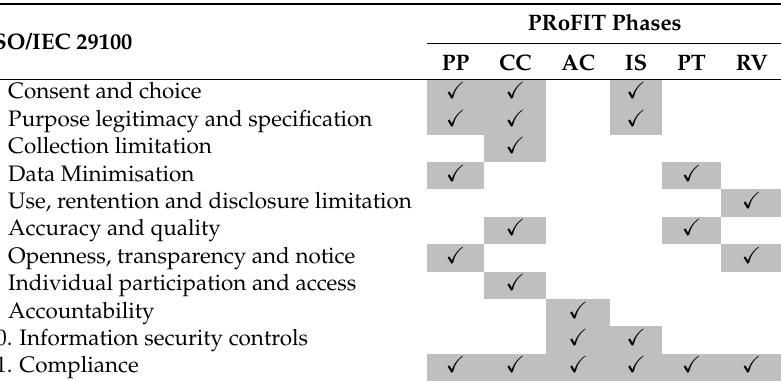
Table 1. Privacy principles in